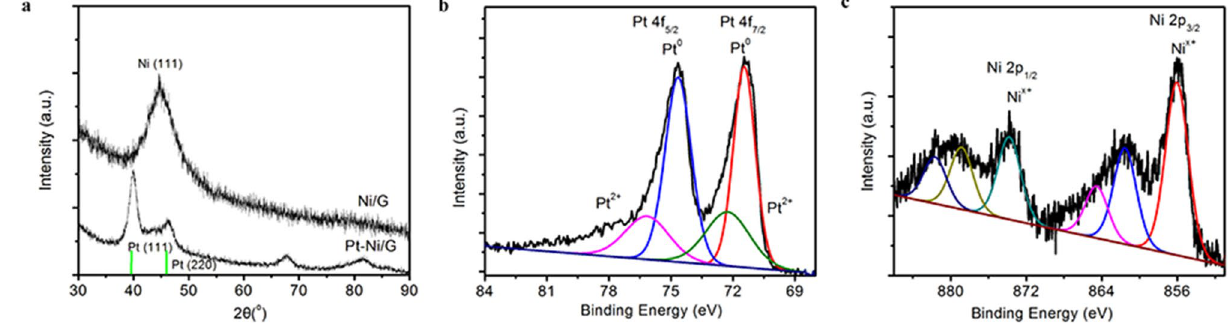
Figure 1. ( a ) X-ray diffraction ptterns of Ni-graphene and PtNi alloy-graphene, XPS spectra of ( b ) Pt 4f and ( c ) Ni 2p for PtNi